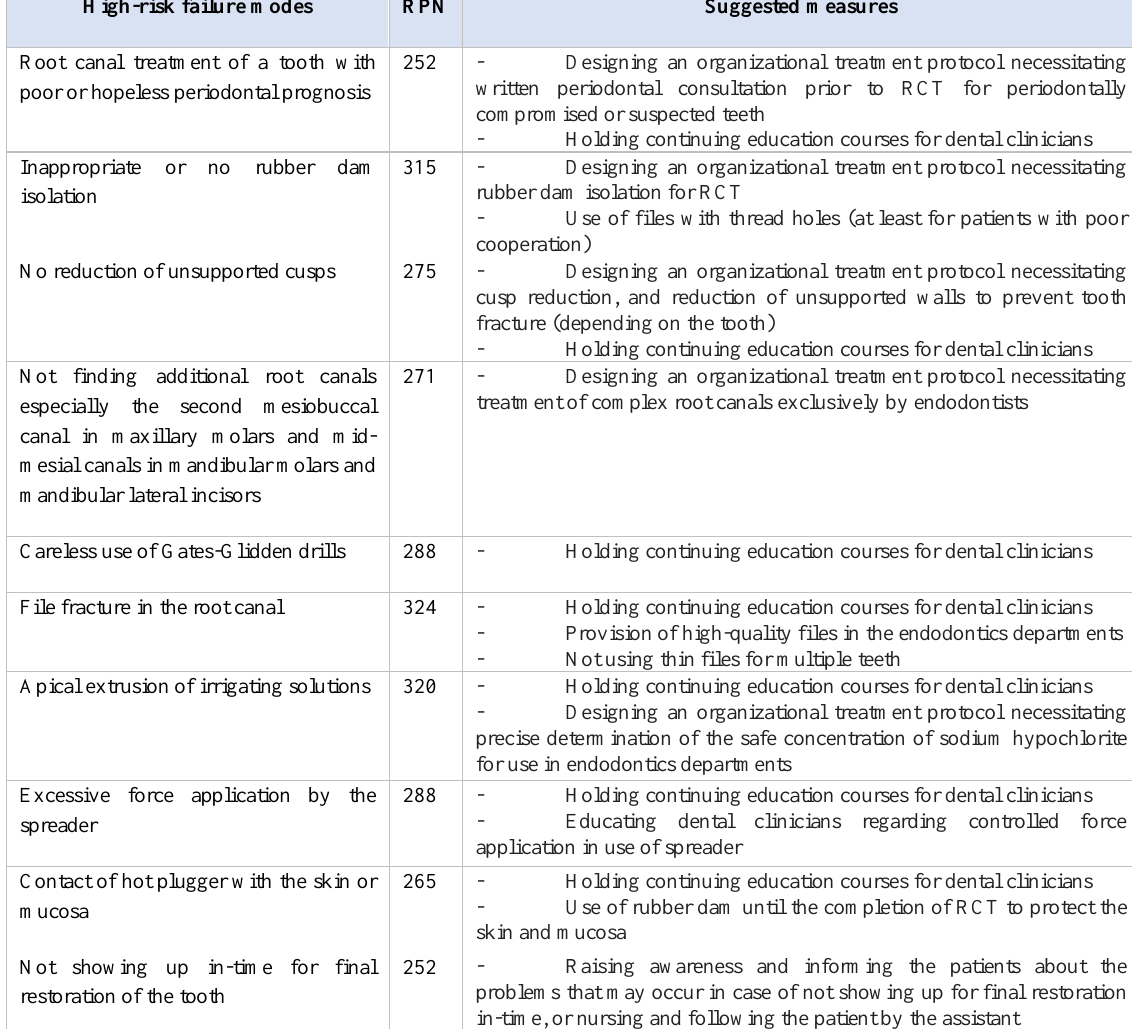
Table 3. Suggested measures for high-risk errors in the process of RCT High-risk failure modes RPN Suggested